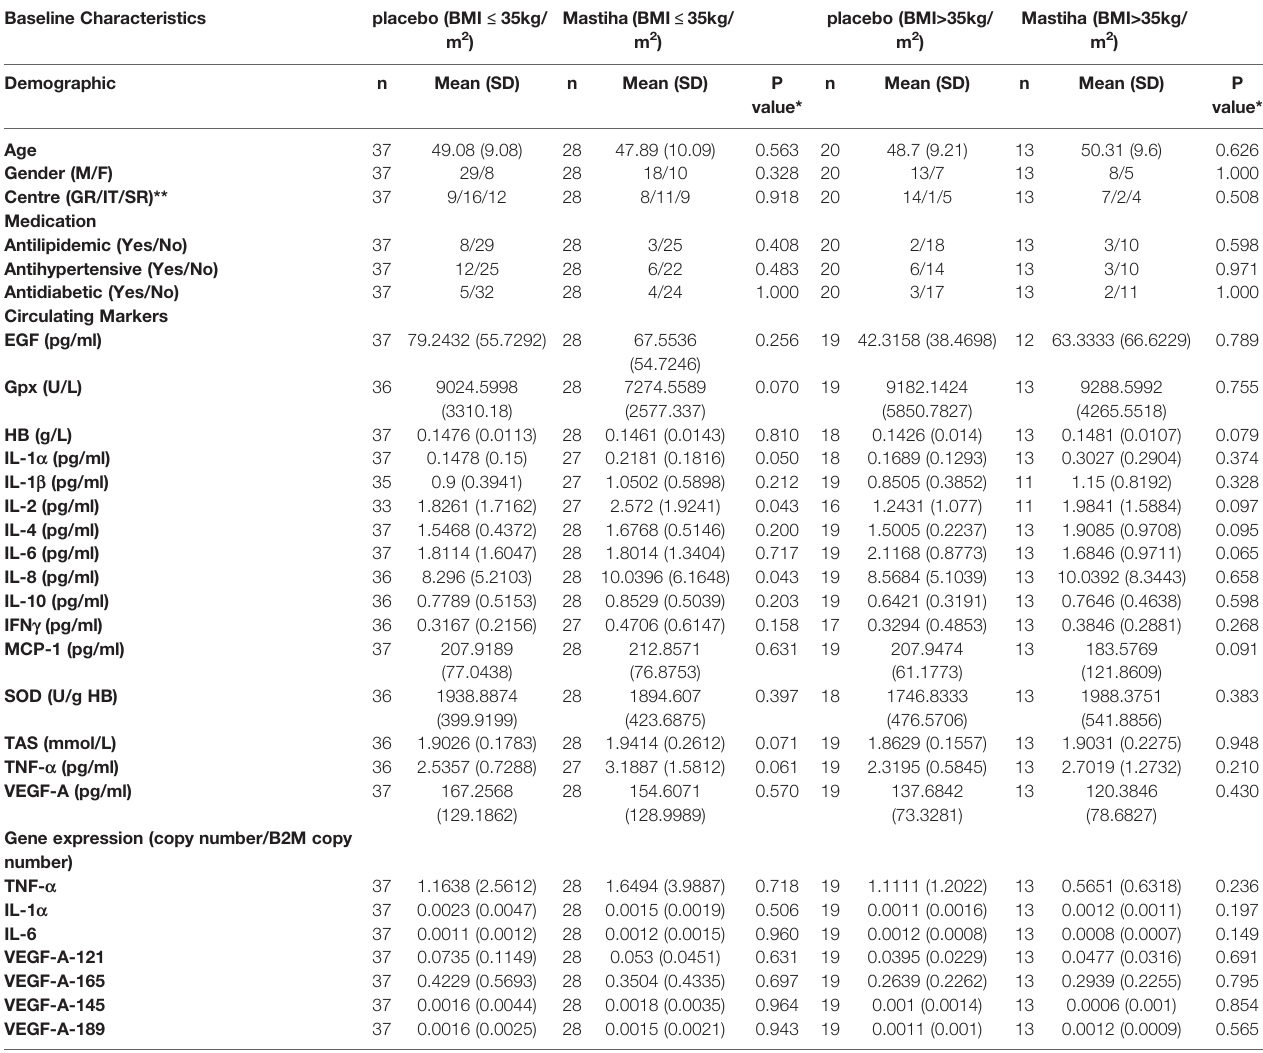
*P value for the trial groups comparison. Outcome comparisons are adjusted for age, sex and center. Differences in categorical variables were assessed with Chi-square test, **GR, Greece; IT, Italy; SR,